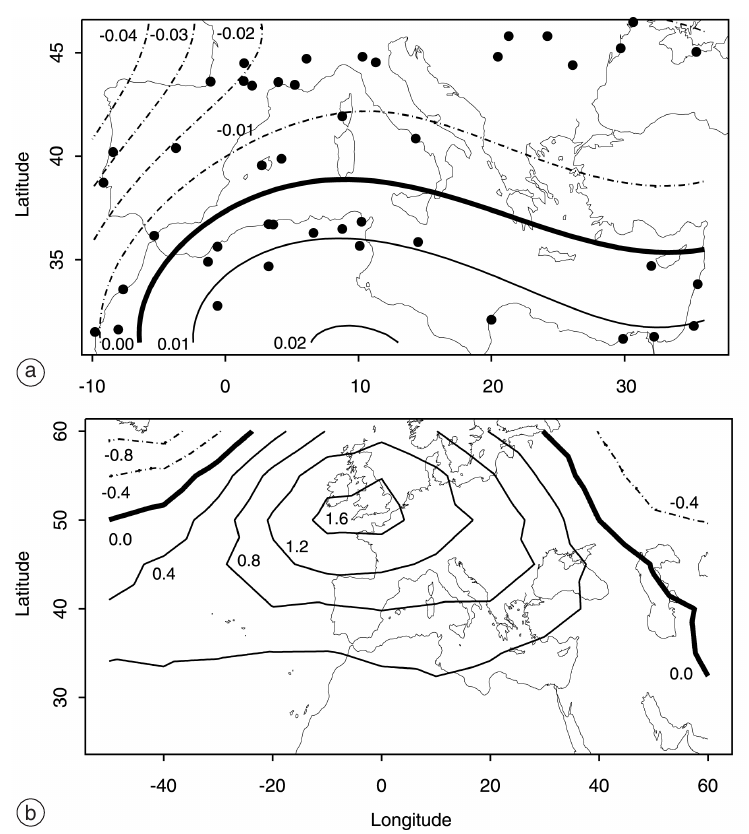
Fig. 4a,b. a) The geographical form of the first precipitation canonical function. The contours indicate equal loading values. Increasing loading values represent increased correlation between the variations of precipitation at that locality and the pressure field. b) The geographical extent of the first pressure canonical function. The contours indicate equal loading values. Increasing loading values represent increased correlation between the variations of pressure at that locality and the whole precipitation field. Thus regions of high loading are partic- ularly responsive. N.B. : the loading values in a) and b) are not directly comparable due to the choice of normal- isation (see text for further